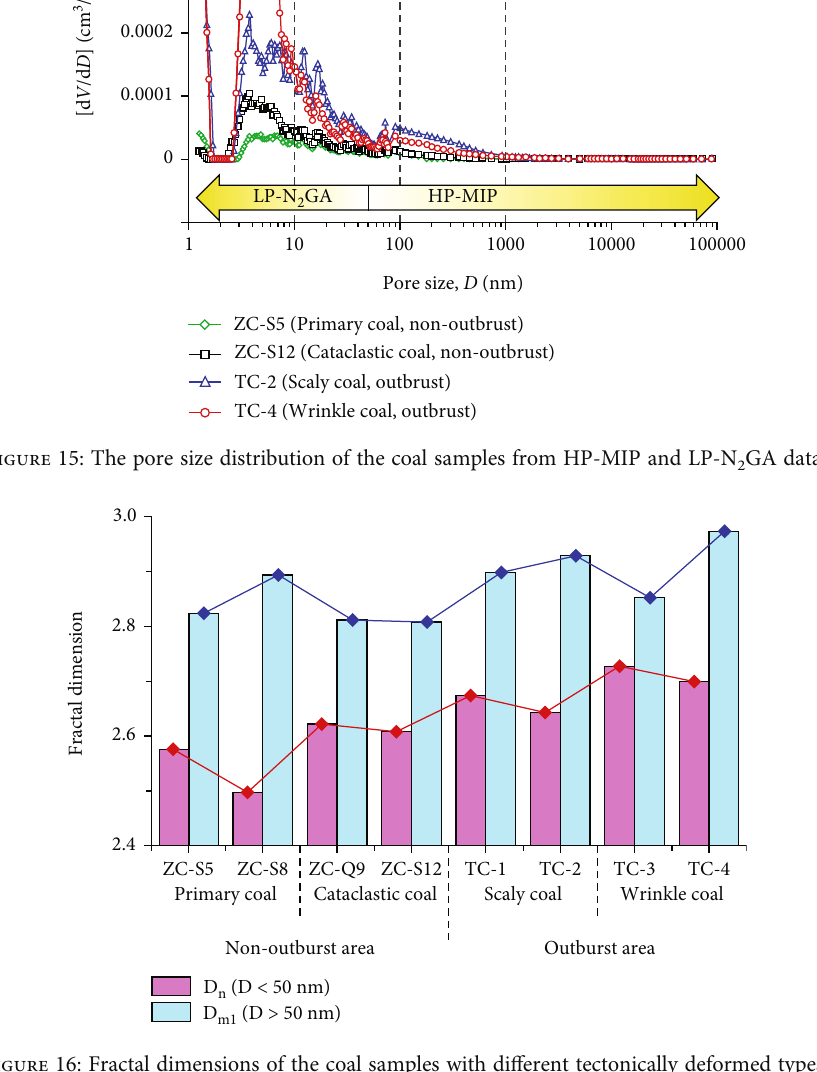
Figure 16: Fractal dimensions of the coal samples with di ff erent tectonically deformed